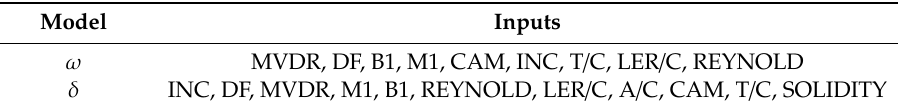
Table 2. Inputs for either model.